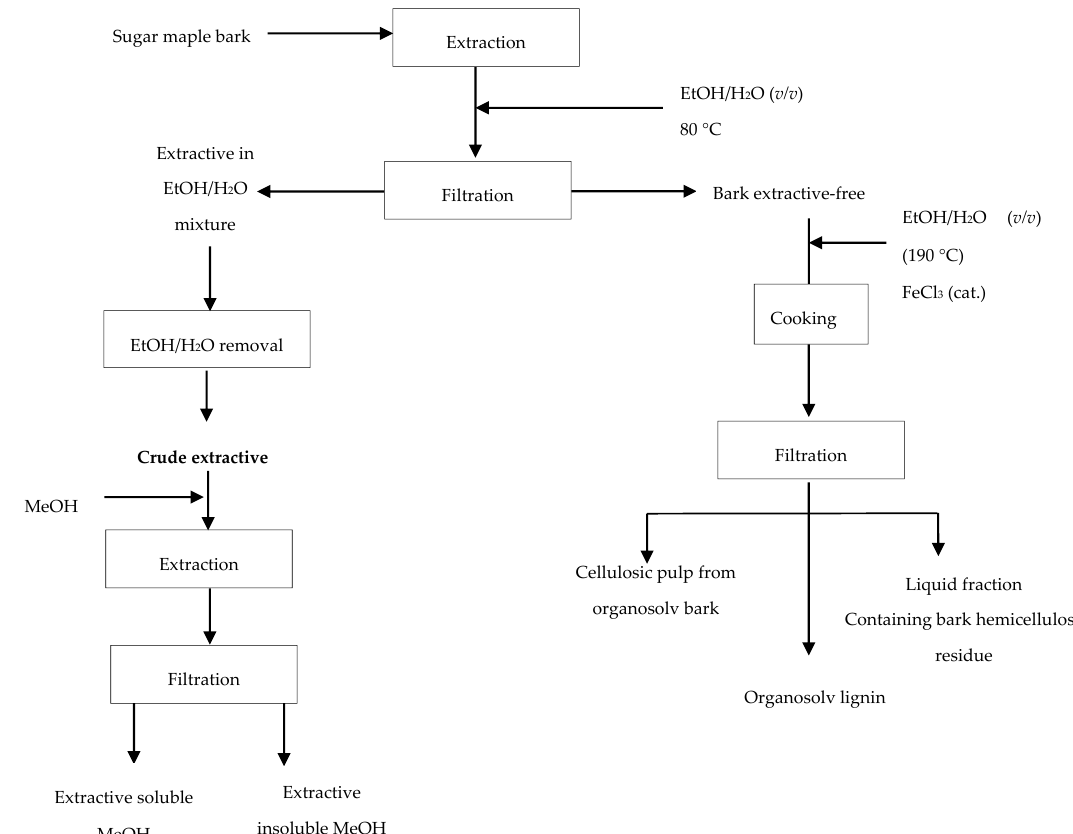
Figure 2. Diagram of biorefinery strategy.